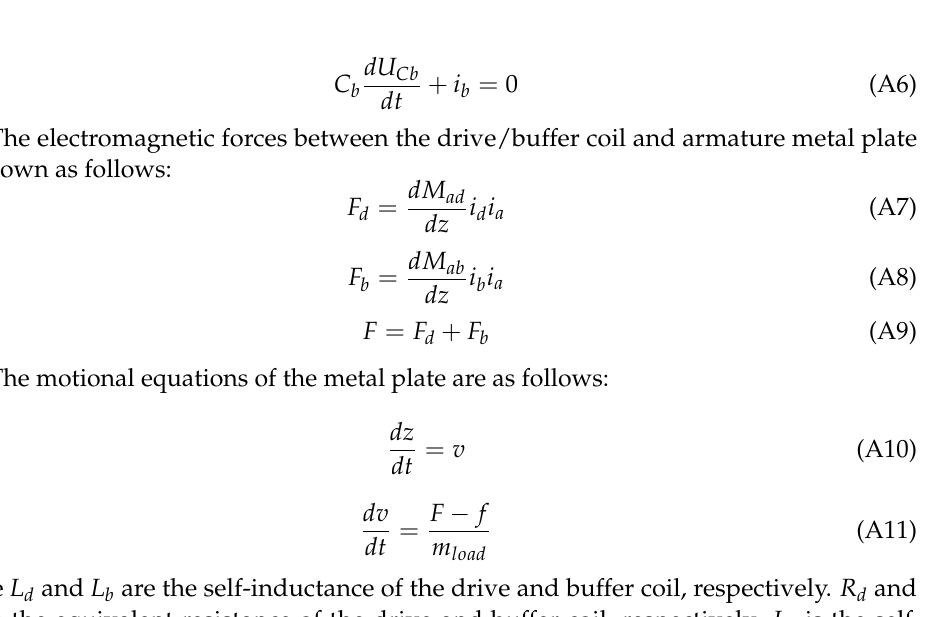
Figure A2. Partition principle of the armature. Based on this modeling technique, the armature plate circuit could be represented by a matrix of L aij , R aij , and i aij, with each corresponding to a mutual inductance matrix M adij and M abij , where i and j represent the segment raw no. and column no., respectively. The ar- mature equation system could be rewritten as: 𝐿 (cid:3028) = (cid:3533) 𝐿 (cid:3028)(cid:3036)(cid:3037) (cid:3041),(cid:3040)